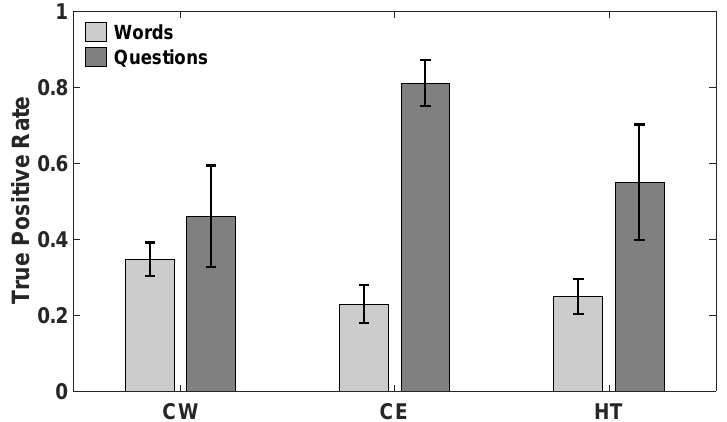
Figure 3. True positive rate for all maskers, both in the word spotting and question answering tasks. HT indicates the case of Heavy Traffic noise; CW refers to Construction Work noise; while CE indicates the case of Car Engine noise. The figure reports the mean and standard deviation (on error bars) across all